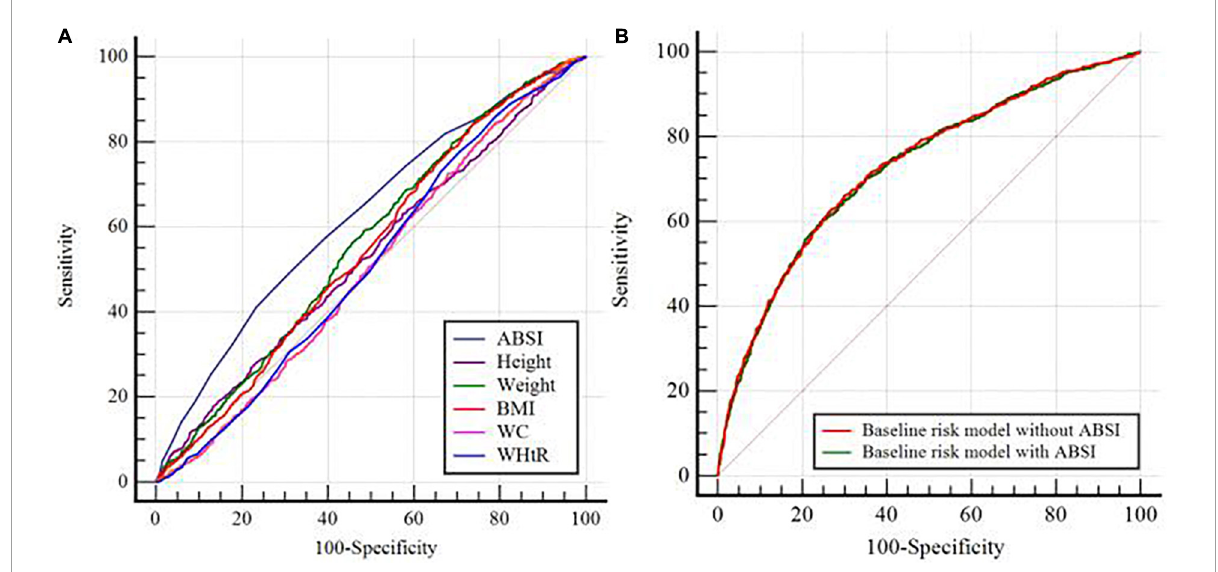
FIGURE5 C-statistics evaluating incremental effect of different models. (A) ABSI vs. Height or Weight or BMI or WC or WHtR; (B) Baseline risk model without ABSI vs. Baseline risk model with ABSI. ABSI, a body shape index; BMI, body mass index; WC, waist circumference; WHtR, waist-to-height ratio. The baseline risk model included age, smoking history, diabetes, hypertension, osteoporosis, systolic blood pressure, triglycerides, total cholesterol, fasting plasma glucose, hemoglobin A1c, creatinine, uric acid, alkaline phosphatase, total calcium, and